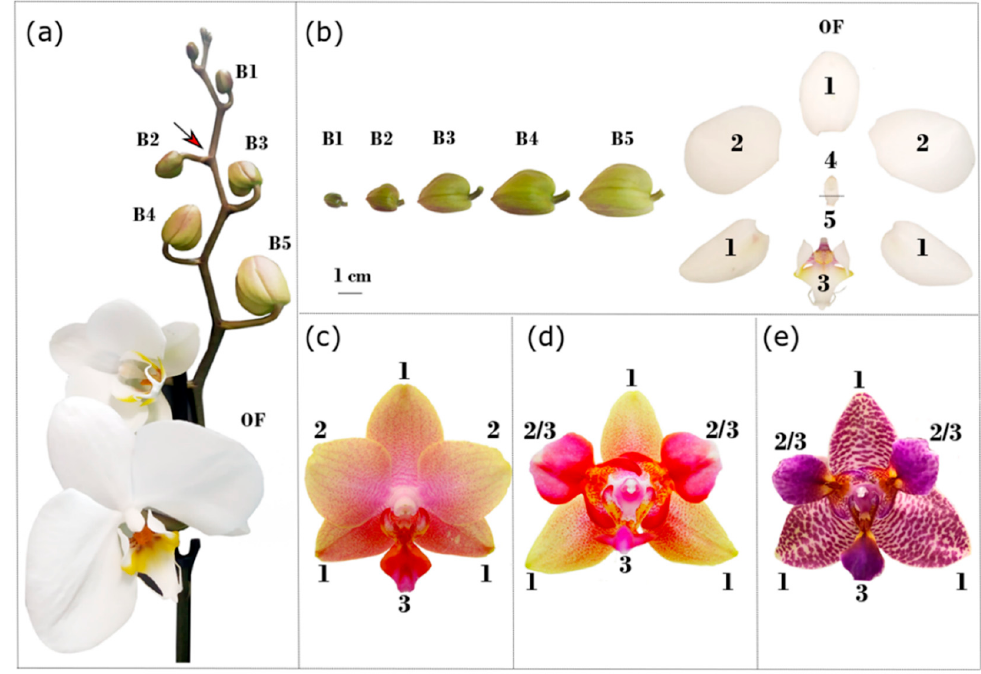
Figure 1. Wild-type and peloric mutants of Phalaenopsis . ( a ) Wild-type P. aphrodite ; ( b ) floral buds at stages B1–B5 and floral organs at the OF stage of the wild-type P. aphrodite ; ( c ) flower of the wild-type Phalaenopsis hyb. “Athens”; ( d ) flower of the peloric mutant Phalaenopsis hyb. “Athens”; ( e ) flower of the peloric mutant Phalaenopsis hyb. “Joy Fairy Tale”. The arrow in (a) indicates the point of rotation of the pedicel during resupination. Size of the developmental stages: B1 (0.5–1 cm), B2 (1–1.5 cm), B3 (1.5–2 cm), B4 (2–2.5 cm), B5 (2.5–3 cm), OF (open flower). 1, outer tepals; 2, lateral inner tepals; 3, labellum; 4, column; 5, ovary; 2/3, labellum-like organs.